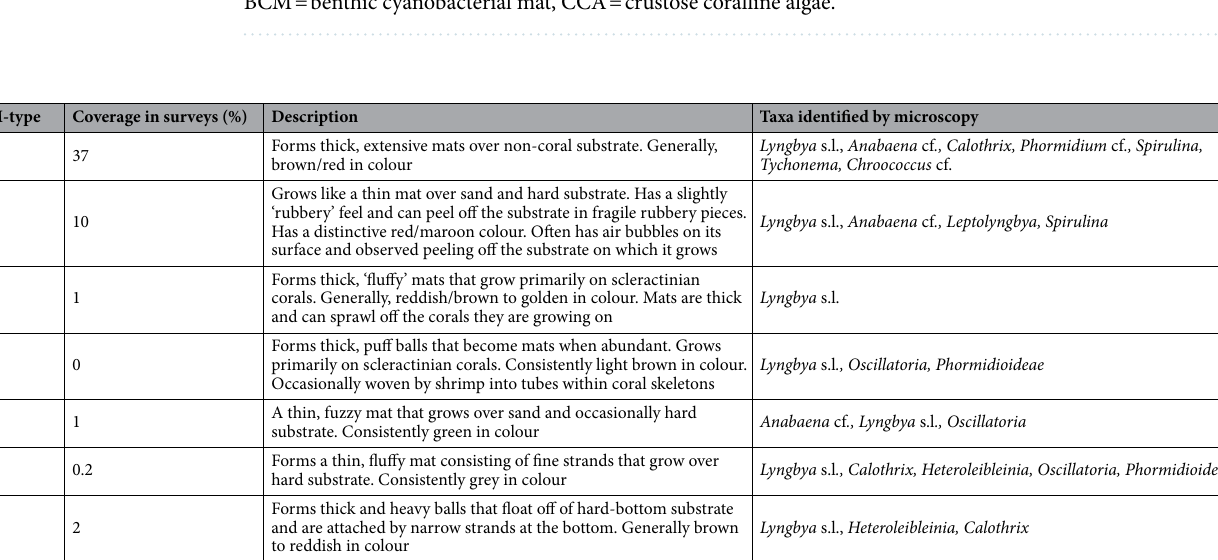
Figure 1. Survey data from the study site within the Namada no-take area: ( a ) benthic cover determined by benthic point-intercept transects (mean ± s.e.m.), ( b ) relative proportion of substrate types over which BCMs were growing, ( c ) herbivorous fish biomass by functional group according to stationary point counts (mean ± s.e.m.), and ( d ) number of species observed over all stationary point counts by functional group. BCM = benthic cyanobacterial mat, CCA = crustose coralline algae.